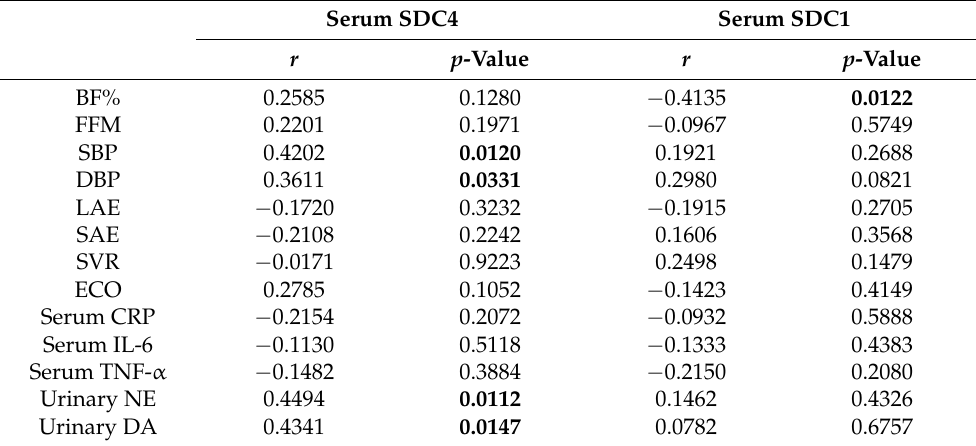
Table 2. Correlations between serum levels of SDCs and study